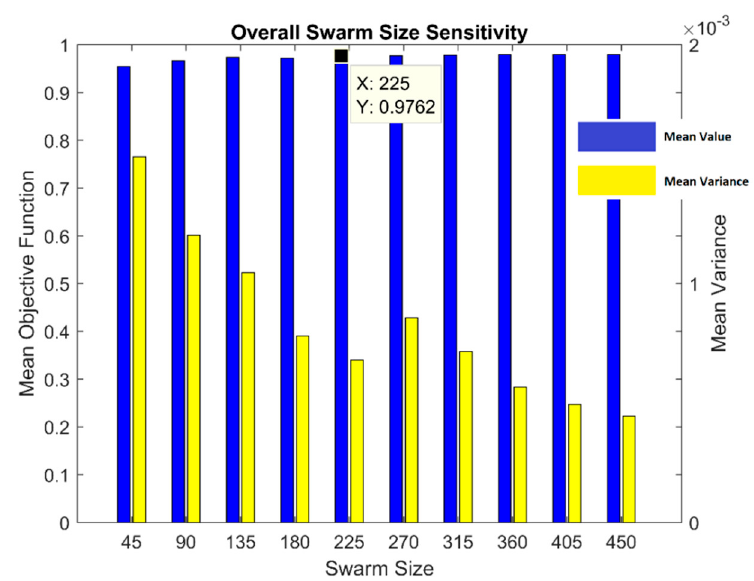
Figure 12. Sensitivity analysis of PSO evaluating the swarm size.